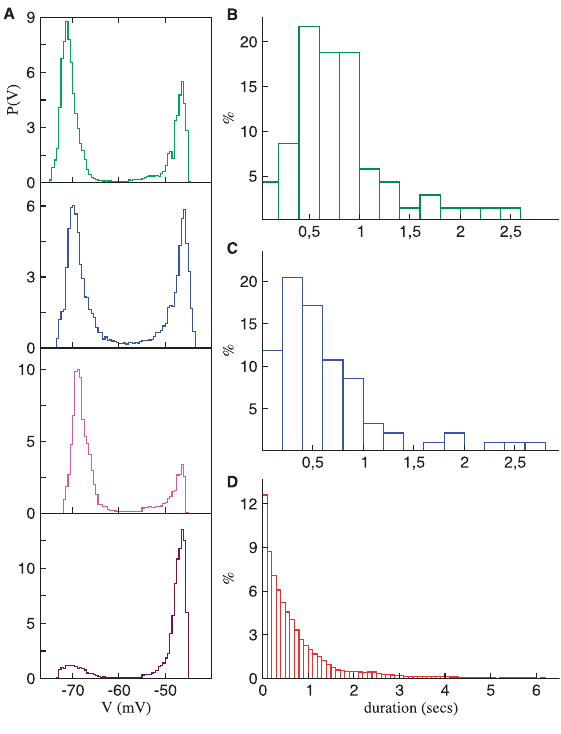
Figure3. Characterizationoftheslowfluctuationsoftheregularnetwork . (A) Potential distributions of the four neurons shown in Figure 2D . Note that the neuron shown at the bottom (brown line) stays most of the time in the up state. (B–C) Histograms for the duration of the up states of two bimodal neurons. The simulation time was 100seconds. (D) Histogram of the duration of the up states computed from all the neurons in the